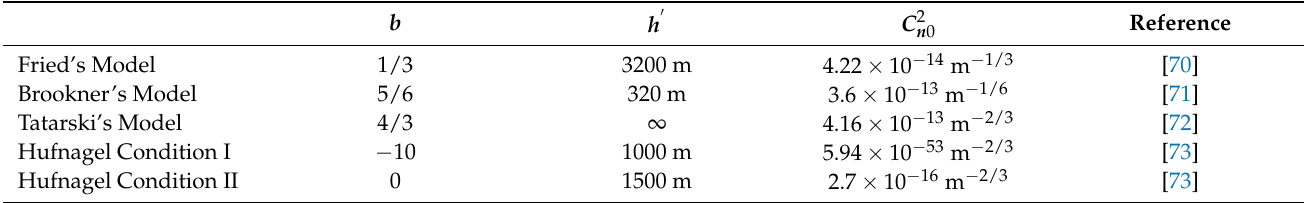
Table 9. Refractive index structure coefficient model parameters.